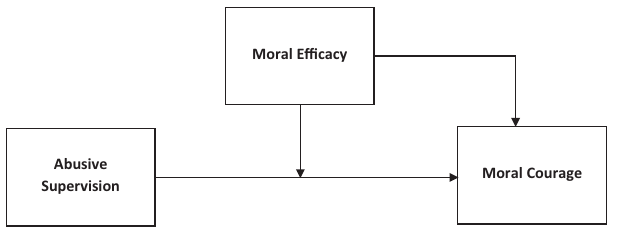
Figure 1. Conceptual model